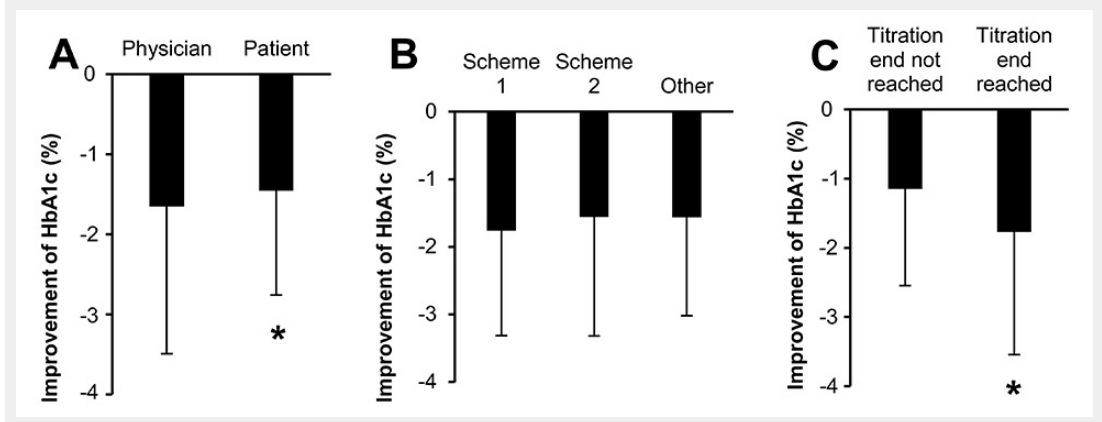
Figure 3 Improvement of HbA 1c with the different titration schemes. A) Physician = titration managed by physician (n = 221), patient = titration managed by patient (n = 91); p = 0.049, adjusted for baseline HbA 1c . B) Improvement of HbA 1c in the different titration groups. 1 = change of 2 U every 3 days (n = 58), 2 = weekly adjustment (n = 230), 2 = other titration scheme (n = 27), p = not significant, adjusted for baseline HbA 1c . C) Titration end not reached (n = 87), Titration end reached (n = 228); p <0.001, adjusted for baseline HbA 1c